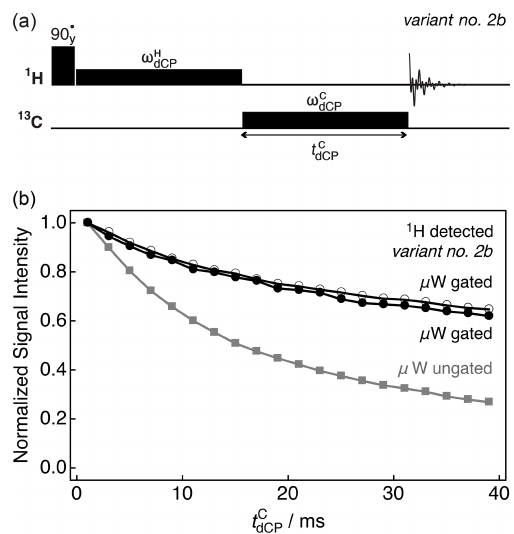
Figure 4. (a) Simplified schematic representation of variant no. 2b of the d CP rf-pulse sequence. (b) Experimental 1 H NMR signal in- tensity of I as a function of the 13 C d CP rf-pulse duration t C ac- ac- d CP d CP quired at 7.05T ( 1 H nuclear Larmor frequency = 300 . 13MHz; 13 C nuclear Larmor frequency = 75 . 47MHz) and 1.2K with two tran- sients per data point. The experimental traces were recorded by us- ing the following amplitudes for the 13 C d CP rf-pulse ω C : black d CP = 0kHz; black filled circles: ω C = 13 . 2kHz; open circles: ω C d CP d CP = 13 . 2kHz. All signal amplitudes were normal- grey squares: ω C d CP ized to the first data